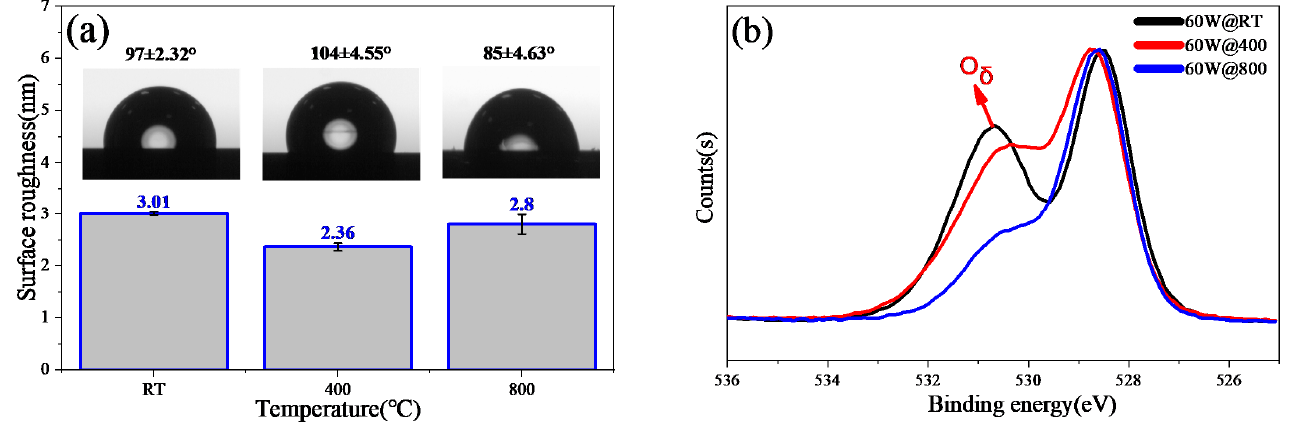
Figure 8. ( a ) The surface roughness and the water contact angles, ( b ) the XPS spectra of the oxygen of the Y 2 O 3 film (sample 2-2) annealed at different temperatures.